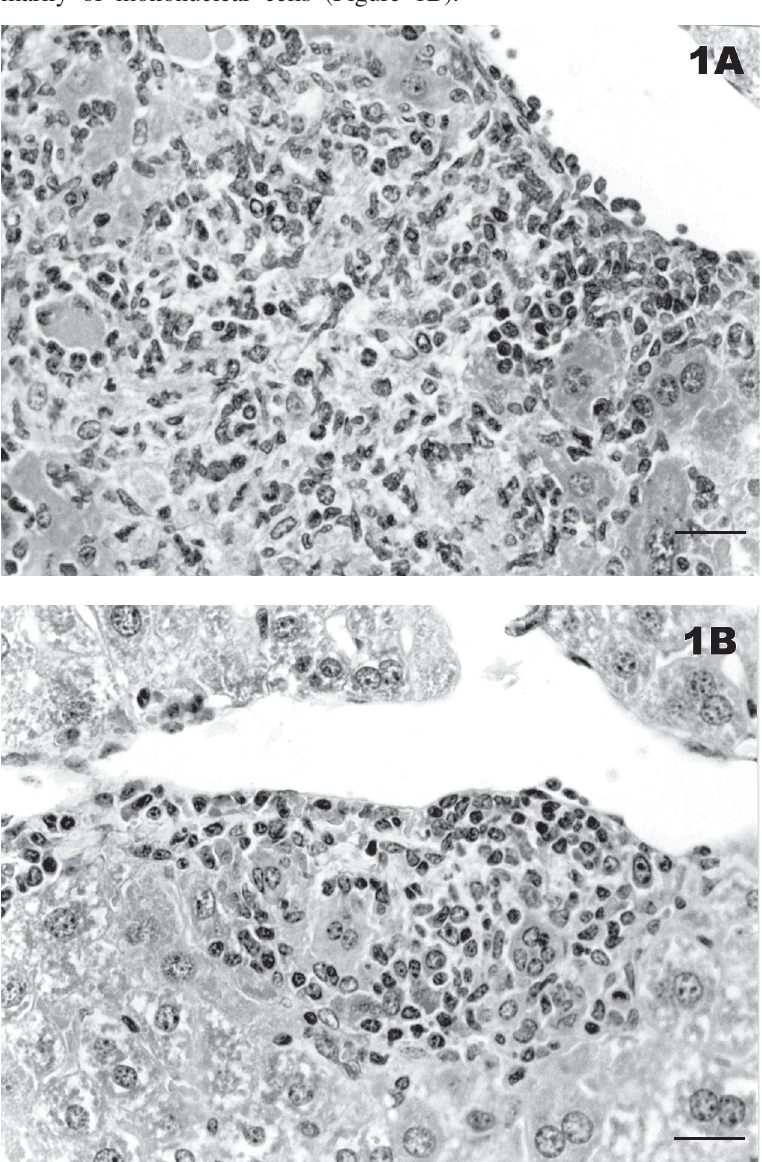
Figure 1. Histologic sections from the liver of germ-free mice infected with Helicobacter trogontum . A , Illustration of an inflammatory infiltrate with mononuclear and polymorpho- nuclear cells and necrosis of a 6-month-infected mouse, and B , a focus of mononuclear cells in a 12-month-infected animal (hematoxylin-eosin; 400X). Bar = 25